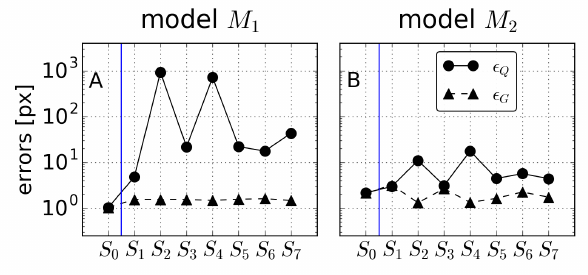
Figure 8. Errors (cid:101) Q and (cid:101) G for angle A 1 and models M 1 ( A ) and M 2 ( B ) as a function of the GCP calibration subset ( S 0 to S 7